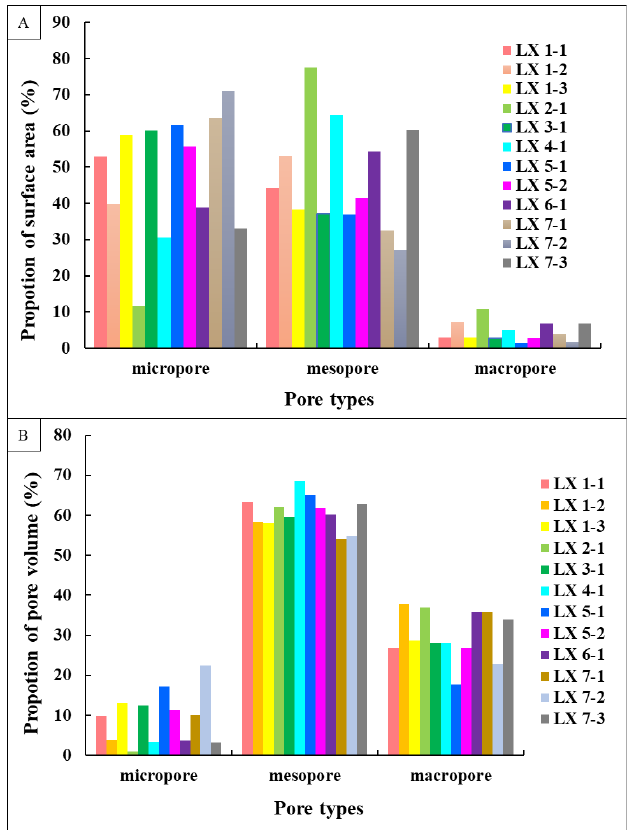
Figure 8. ( A ) Histogram of total specific surface area under different pore sizes of the shales in the study area. ( B ) Histogram of total pore volume under different pore sizes of the shales in the study area.